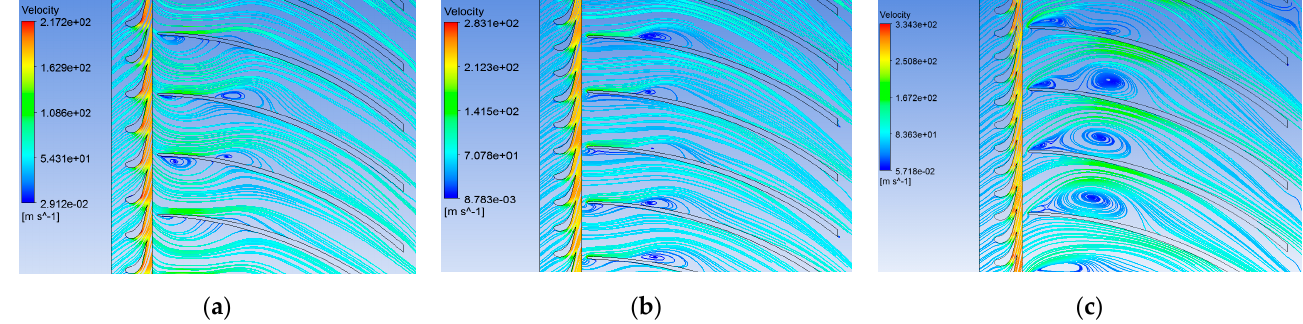
Figure 7. Velocity streamline diagram of 50% leaf height under different number of stator blades. ( a ) The number of stator blades is 24; ( b ) the number of stator blades is 30; ( c ) the number of stator blades is 38.